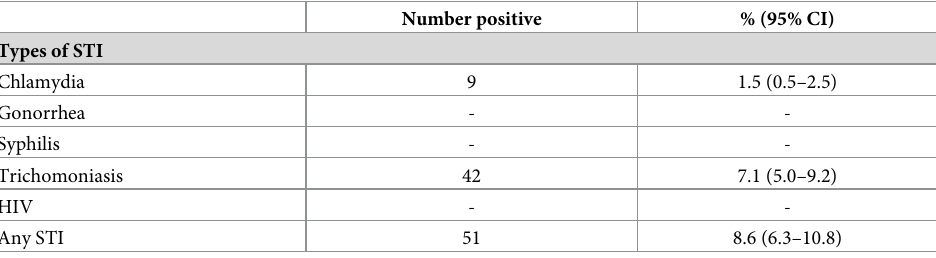
Table 2. Prevalence of STIs among pregnant women visiting antenatal care clinic in Dhulikhel Hospital, Nepal (N =